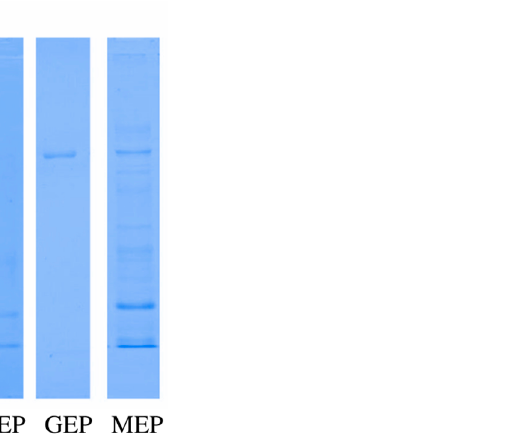
Figure 1. Electrophoretic patterns. Abbreviations: WM, molecular weight marker; TEP, tubular electrophoretic pattern; GEP glomerular electrophoretic pattern; MEP, mixed electrophoretic pattern. Blood pressure was measured indirectly using an oscillometer (Vet 20, SunTech